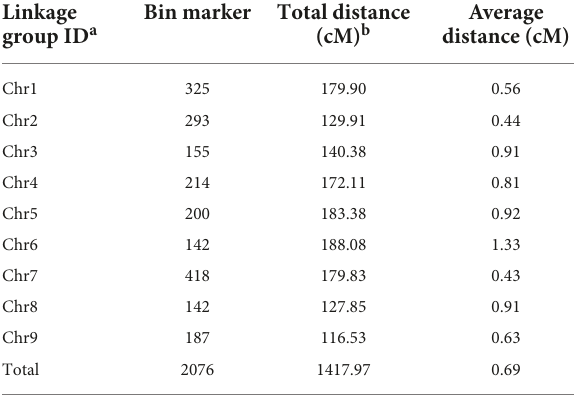
TABLE 2 Description of the basic characteristics of the genetic map for foxtail millet.